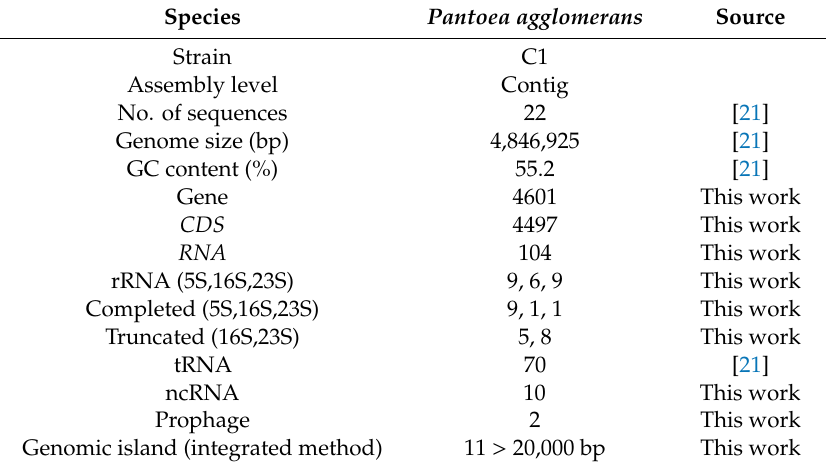
Table 1. General features of P. agglomerans C1